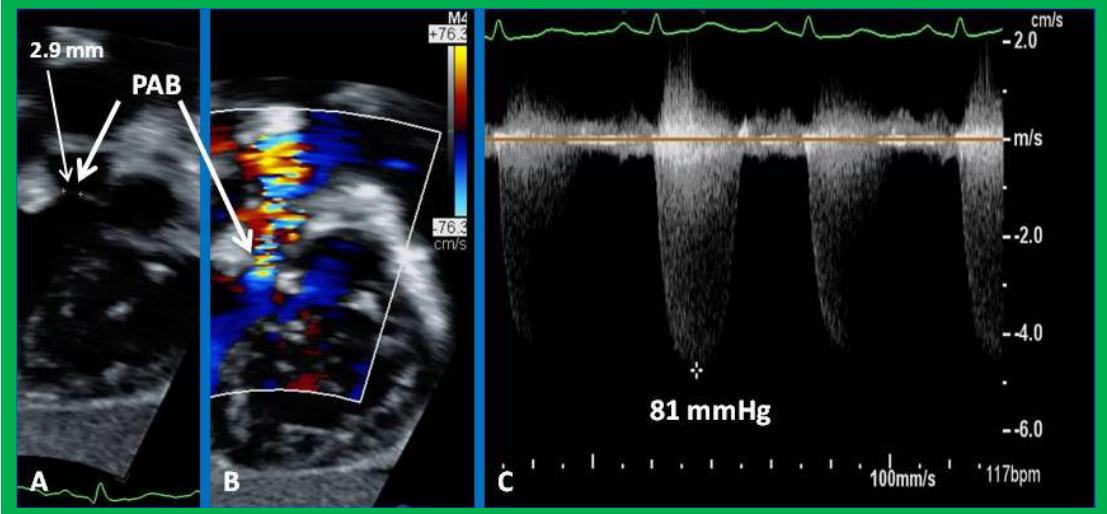
Figure 11. Selected echo–Doppler images demonstrating pulmonary artery band (PAB) which is narrow (2.9 mm) by two–dimensional imaging ( A ) and by color flow Doppler ( B ) and a substantial gradient (81 mmHg) by continuous wave Doppler interrogation ( C ). Reproduced from reference [38].